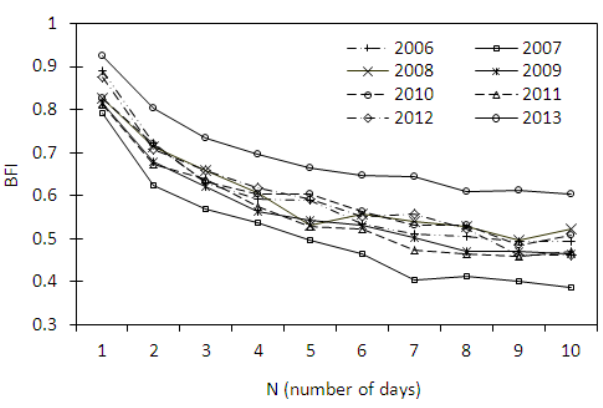
Figure 5. Sensitivity of base-flow index (BFI) to the number of days ( N ) used to select the minimum value in base-flow separation anal- ysis from 2006 to 2013 at the Wuding station located at the outlet of the Qinhuai River